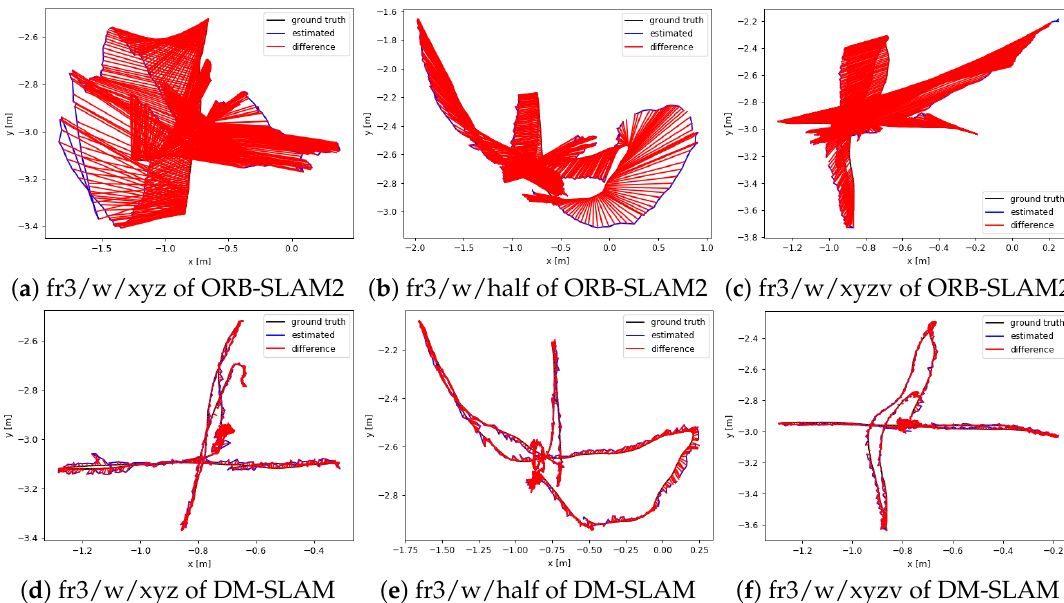
Figure 8. Plots of the ATE [m] for high-dynamic scenes : fr3/w/xyz , fr3/w/half , fr3/w/xyzv . ( a – c ) the experiments performed with ORB-SLAM2; ( d – f ) the experiments performed with